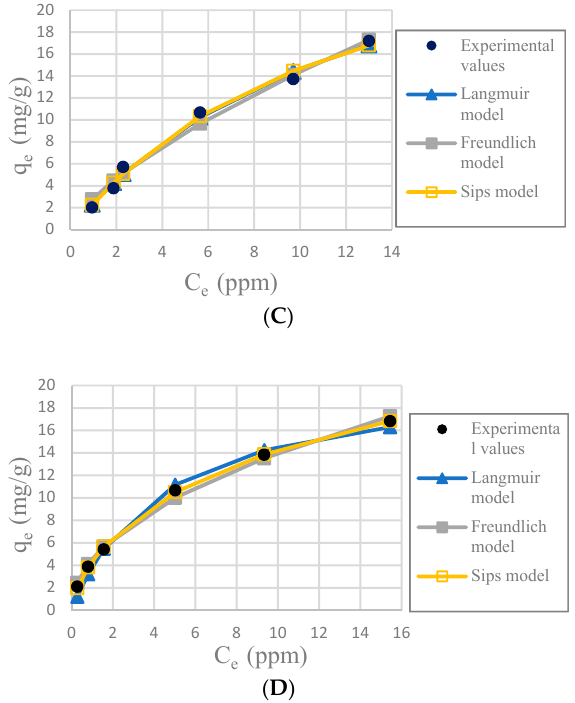
Figure 7. Plots of adsorption isotherms; ( A ): CA-SCGs beads (3:3); ( B ): SCGs; ( C ): CA beads and ( D ): CA-SCGs beads (3/10).